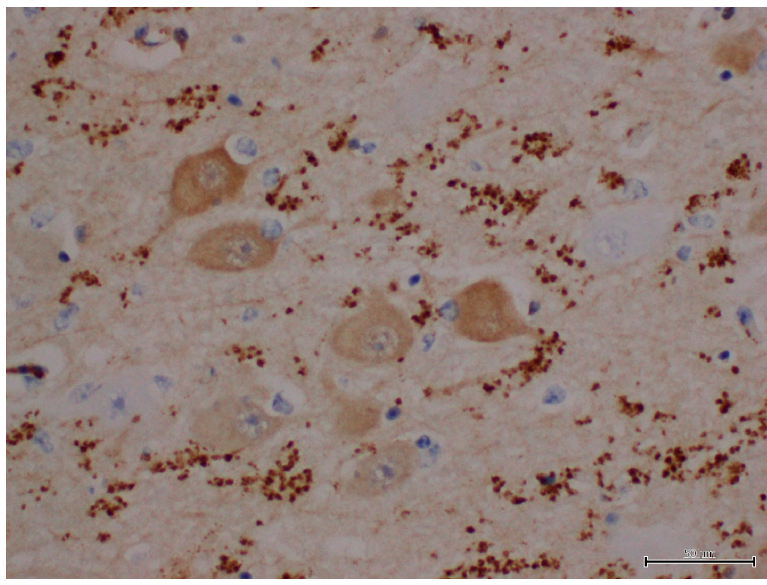
Figure 8. IHC labeling using α -synuclein monoclonal antibodies to label α -synucleins in the neuro- pil of the hippocampus.